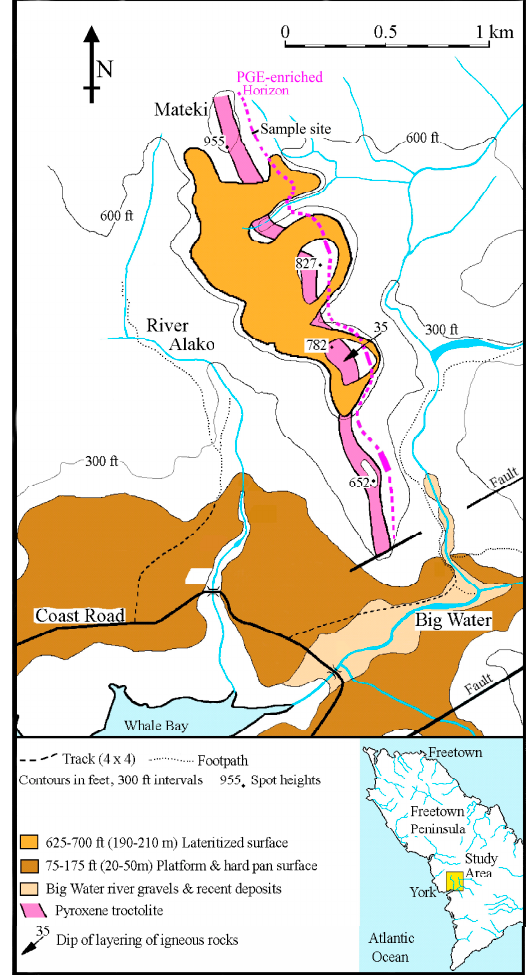
Figure 2. Map of the area inland from York on the Freetown Peninsula, Sierra Leone showing the sample site.